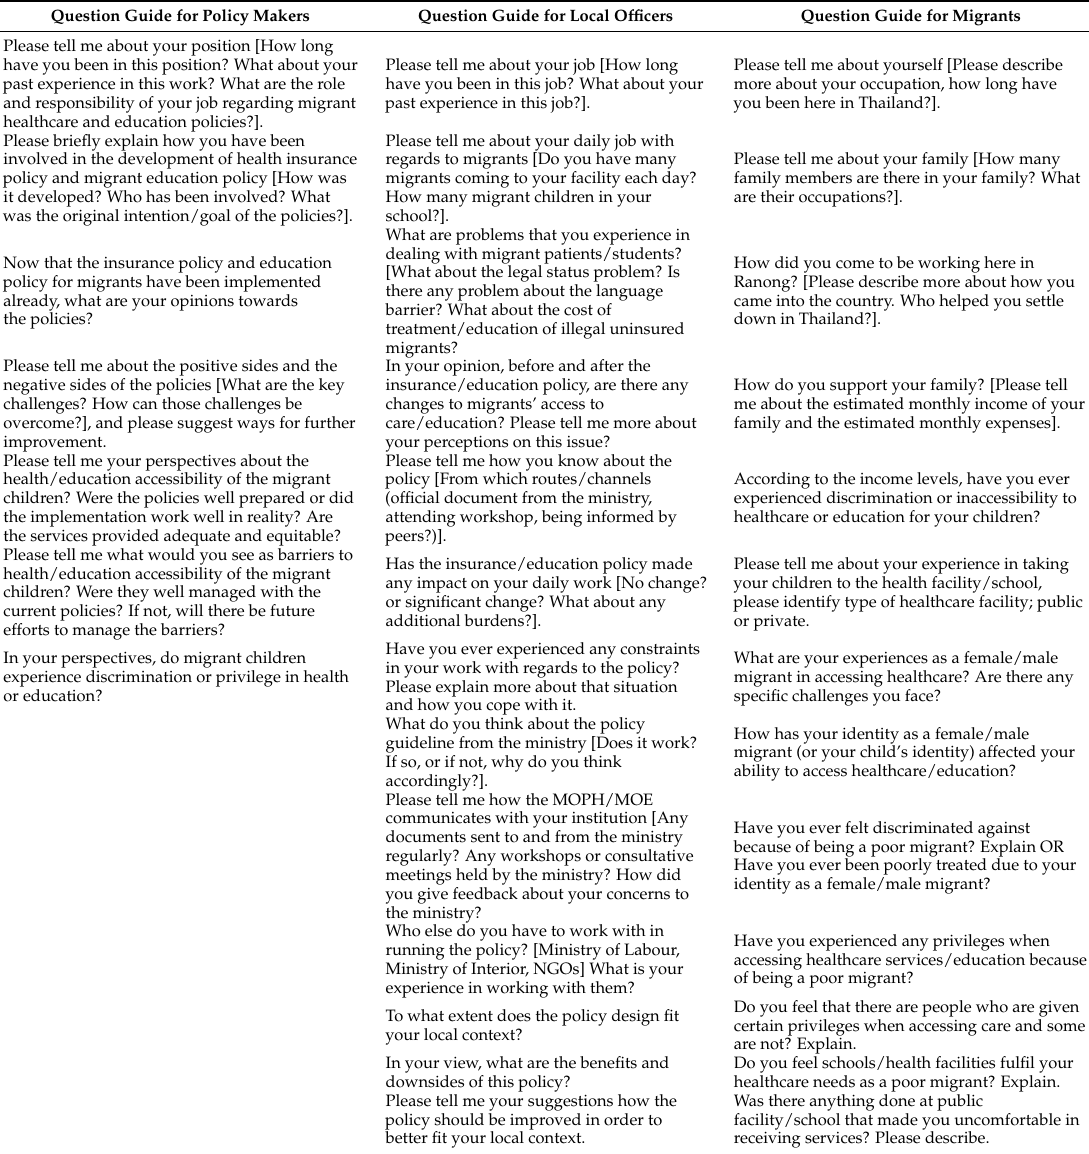
Table 2. Question guide for